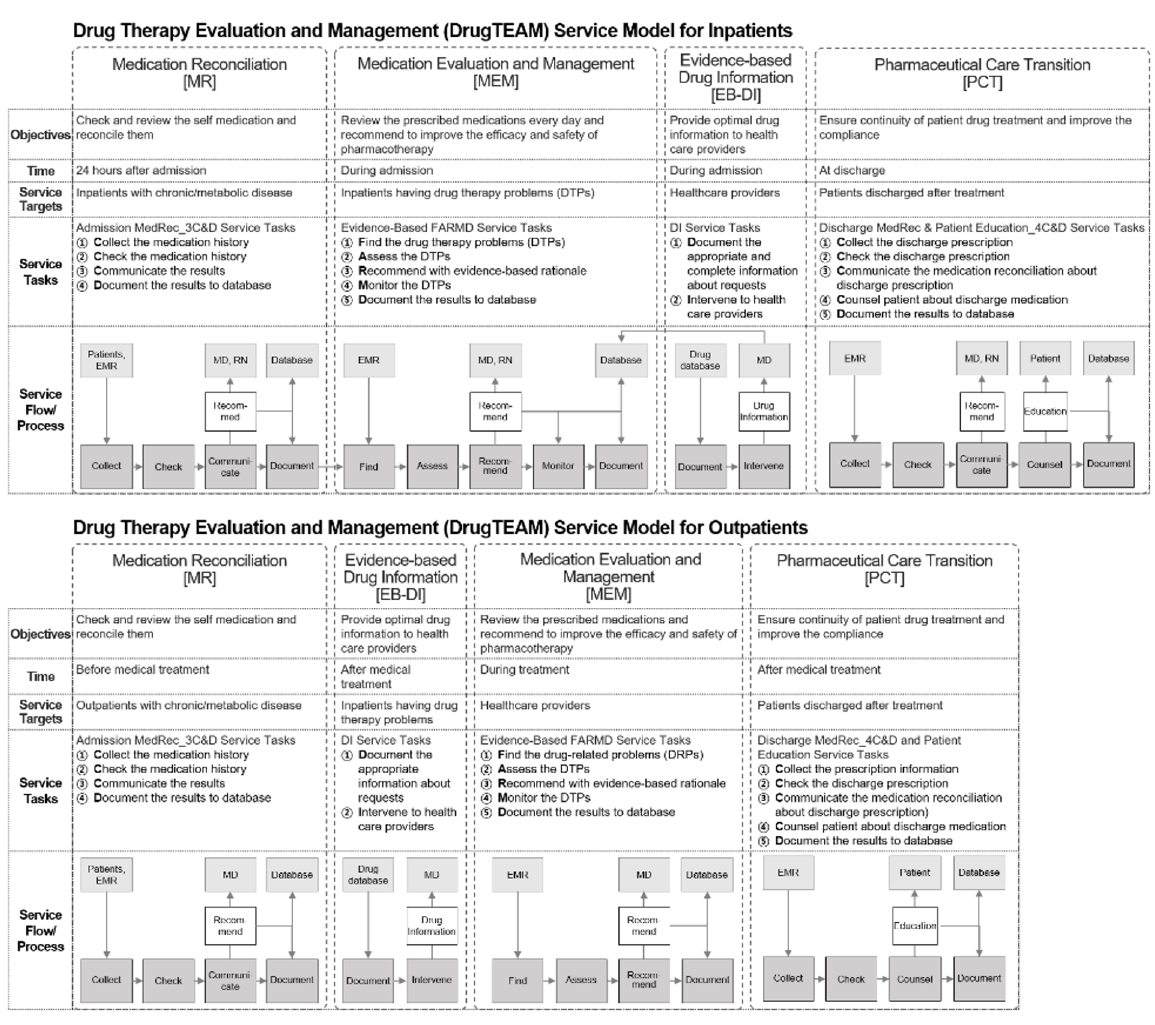
Fig 4. A collaborative multidisciplinary DrugTEAM service models for inpatients and outpatients. (Abbr.: EMR, electronic medical record; MD, medical doctor; RN, registered nurse).